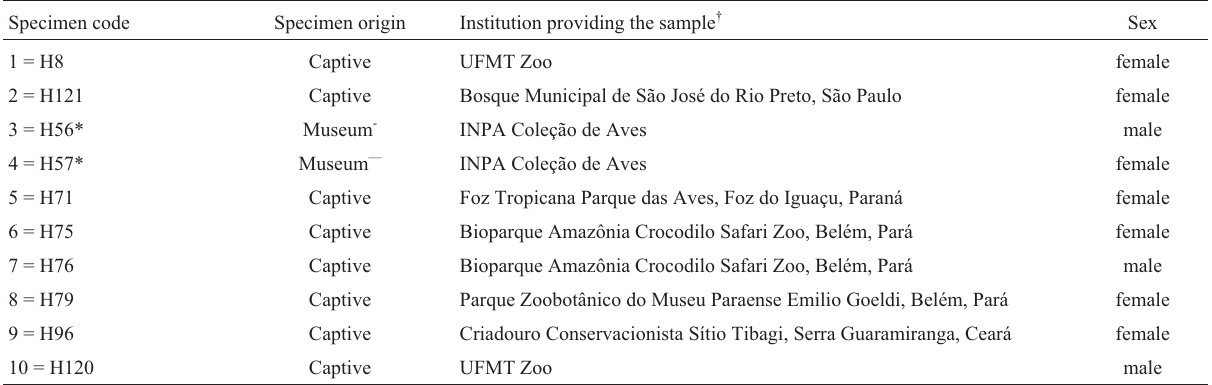
Table 3 - Harpy eagle individuals ( Harpia harpyja ) subjected in the sex-determination. Specimen code